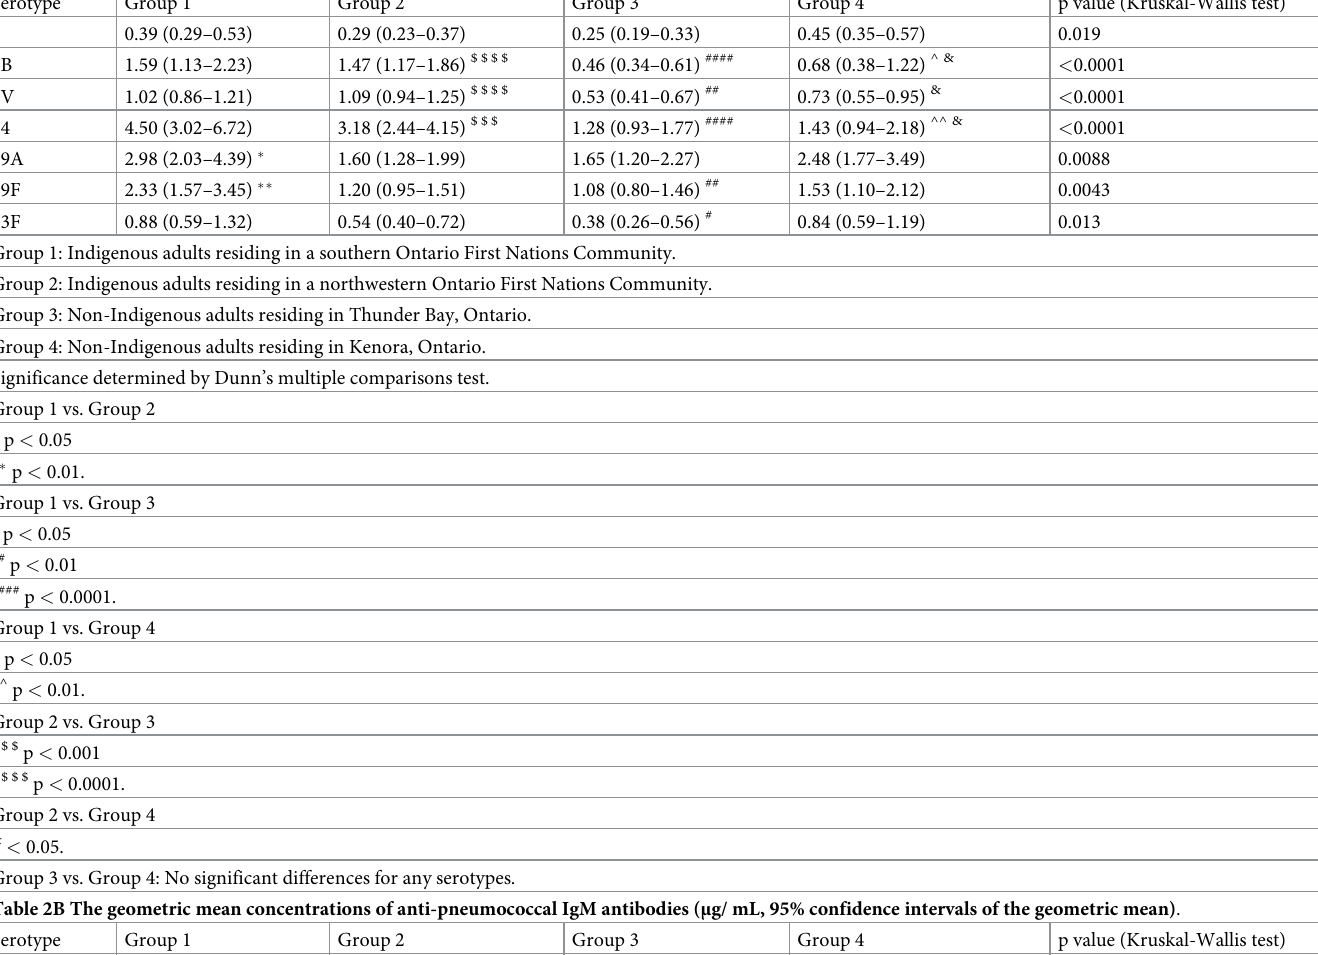
Table 2A. The geometric mean concentrations of anti-pneumococcal IgG antibodies ( μ g/ mL, 95% confidence intervals of the geometric mean). Serotype